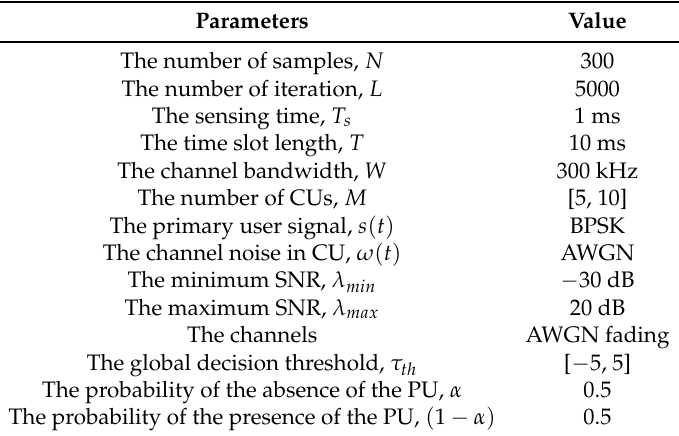
Table 2. Simulation